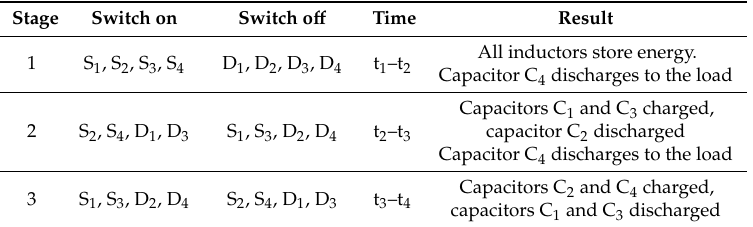
Table 3. The operation states of the circuit when all of the levels are